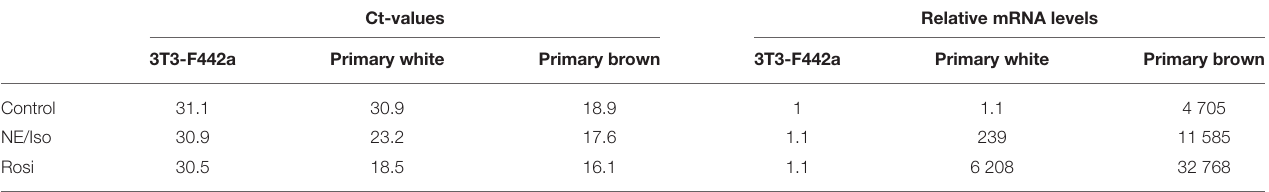
TABLE 2 | A comparison between an established adipogenic cell line and primary cultured white and brown adipocytes with respect to UCP1 mRNA levels.